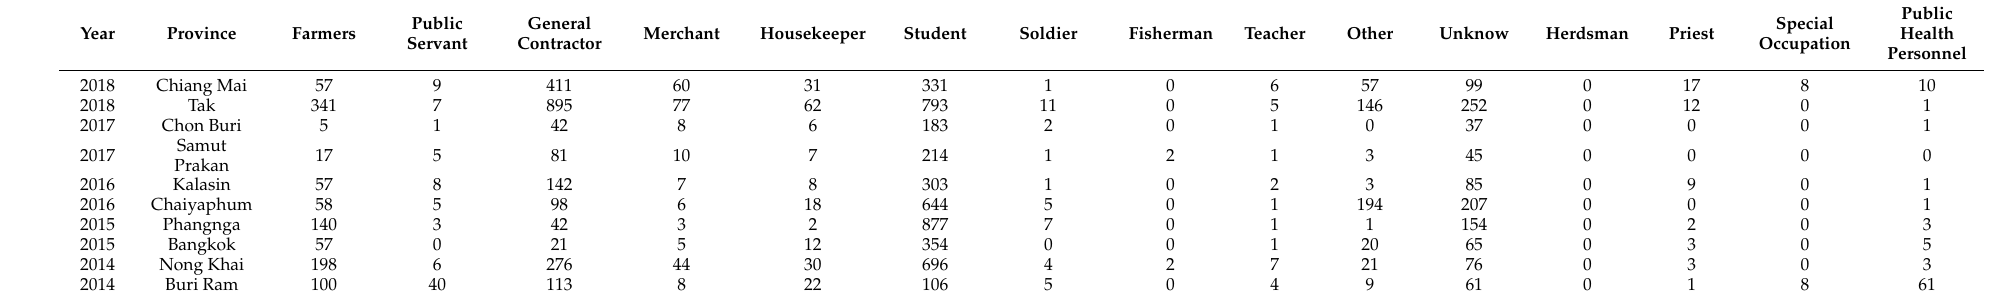
Table 2. Career category report from the dengue fever